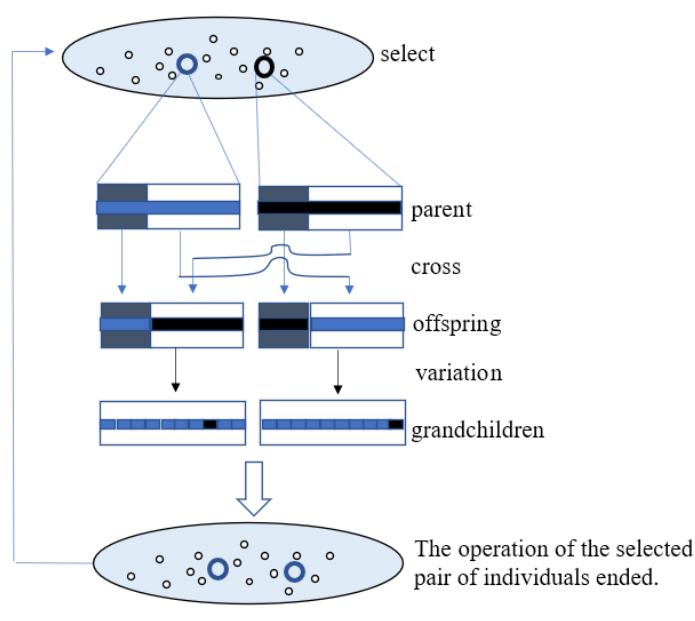
Figure 5. Flow of Figure 5. Flow of MIGA.